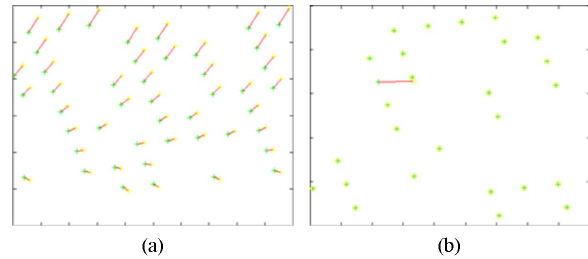
Figure 11: Result of correction with c 1 ( x 0 , y 0 , k 1 , k 2 , sy )and c 2 self-calibration’s paradises for CP. (a): GCP with errors (b):CP corrected by the result of